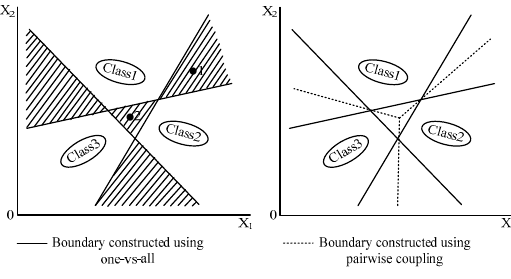
Figure 2. Comparisons between one versus all and one versus one strategy.